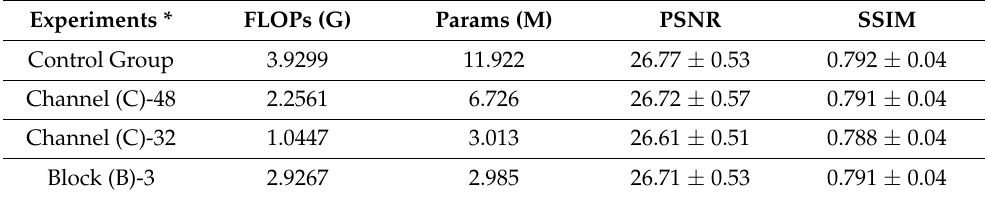
Table 5. Quantitative comparison of the different setups of the LUSwin transformer. Experiments